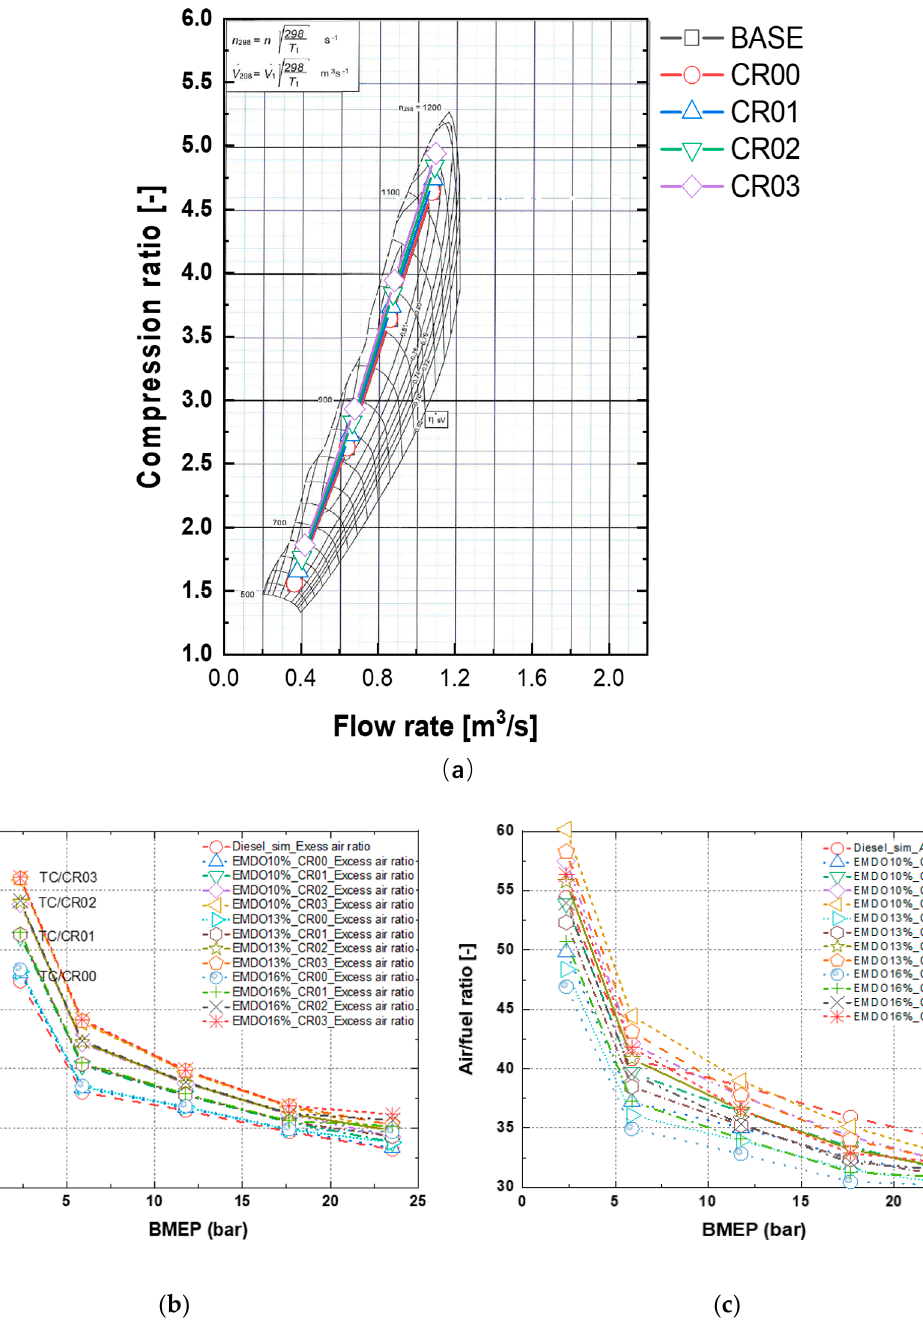
Figure 8. Characteristics of the compression ratio, Air / Fuel ratio and access air ratio of the turbocharger versus the break mean e ff ective pressure (BMEP). ( a ) Turbocharger map, ( b ) access air ratio, ( c ) Air / Fuel ratio.